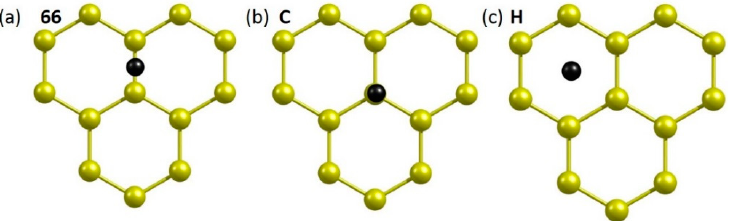
Figure 2. Relaxed structures of N 2 ( a – c ) adsorbed onto the surface of pristine graphene.